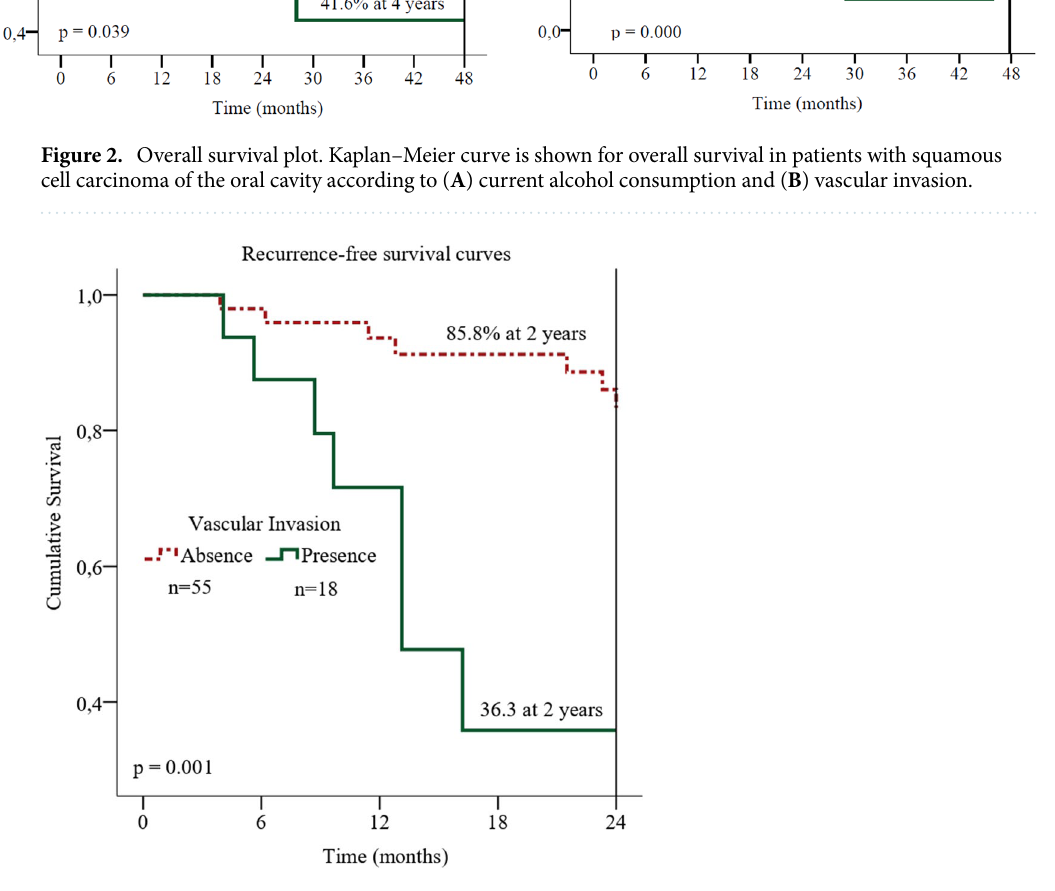
Figure 3. Recurrence-free survival plot. Kaplan–Meier curve is shown for recurrence-free survival in patients with squamous cell carcinoma of the oral cavity according to vascular